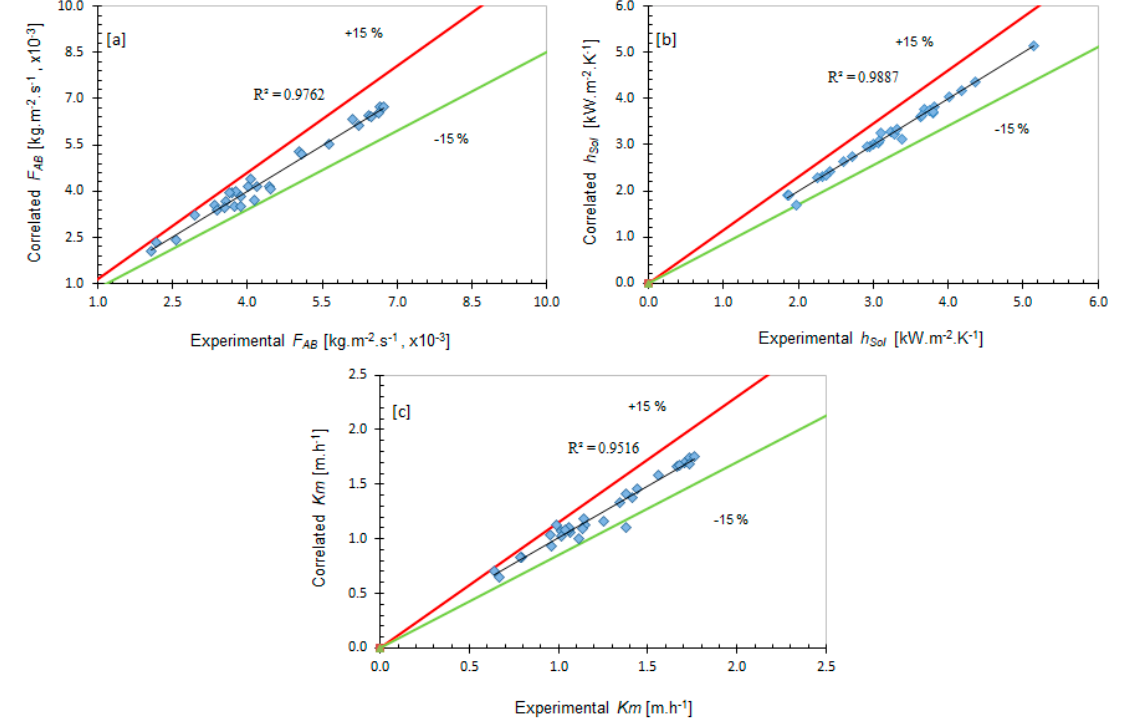
Figure 8. Experimental data vs. correlated data obtained using the ANN model: ( a ) absorption mass flux; ( b ) solution heat transfer coefficient; and ( c ) solution mass transfer coefficient. The ANN model can represent the collected data with average deviations of 4.26%, 4.2%, and 1.74%, for the absorption mass flux, solution heat transfer coefficient, and mass transfer coefficient, respectively. Moreover, the ANN can satisfactorily predict 97% of absorption mass flux data at relative differences below 10%. Similarly, the ANN model can predict 90% and 97% of the solution heat transfer coefficient and mass transfer coefficient data, respectively, at relative differences below 10%. Values of the corresponding fit parameter, R 2 , of the ANN model are indicated in Figure 8.